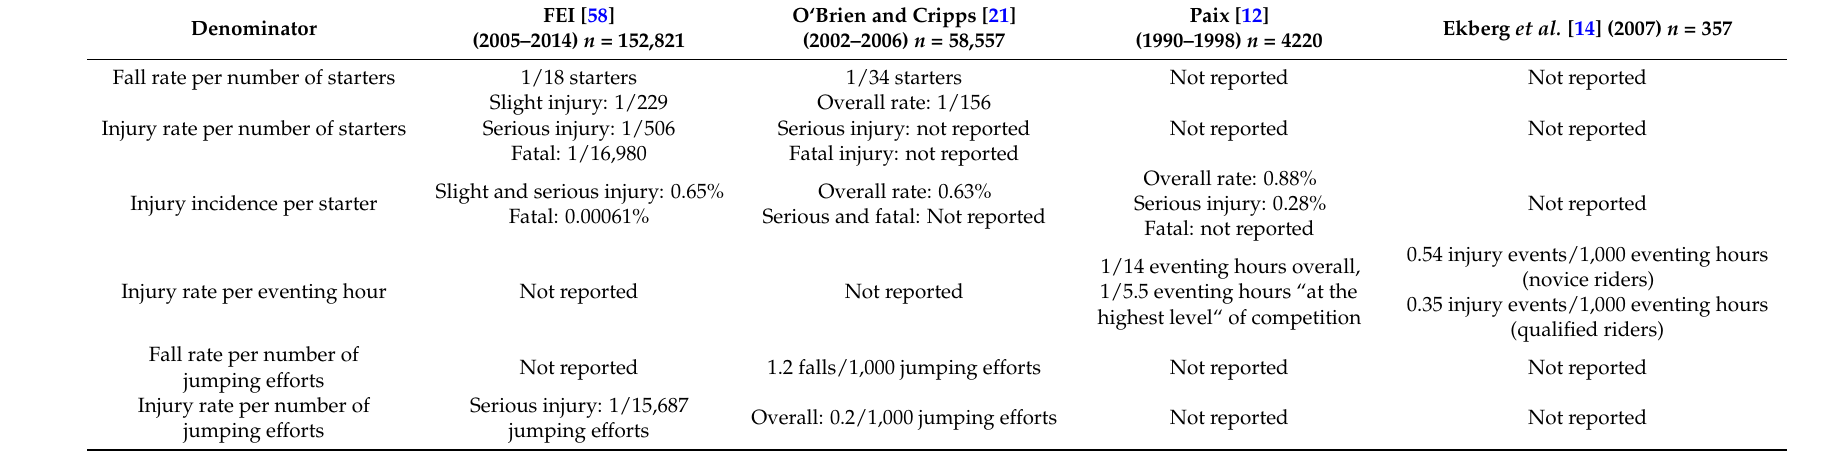
Table 1. Reports of Fall and injury rates in eventing,